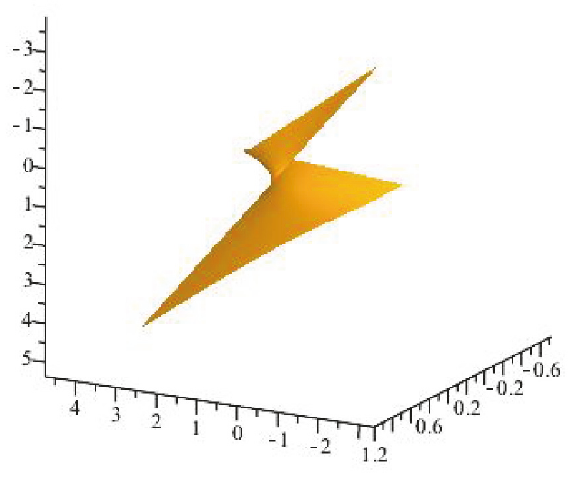
Figure 11: Projection of the intersection of IH 𝛾 ± (𝑠,𝜇, 𝜔) and 𝜔 = 0 on 𝑥 1 𝑥 2 𝑥 3